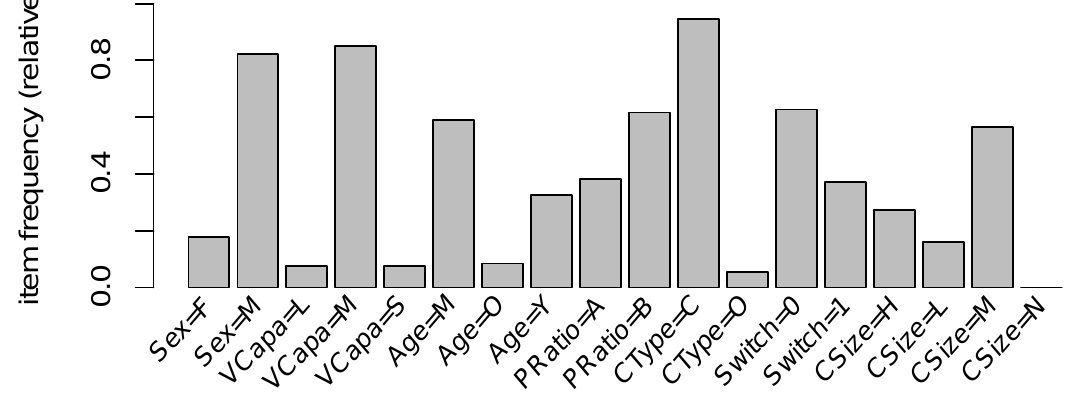
Figure 1. Relative frequency of itemsets in the original